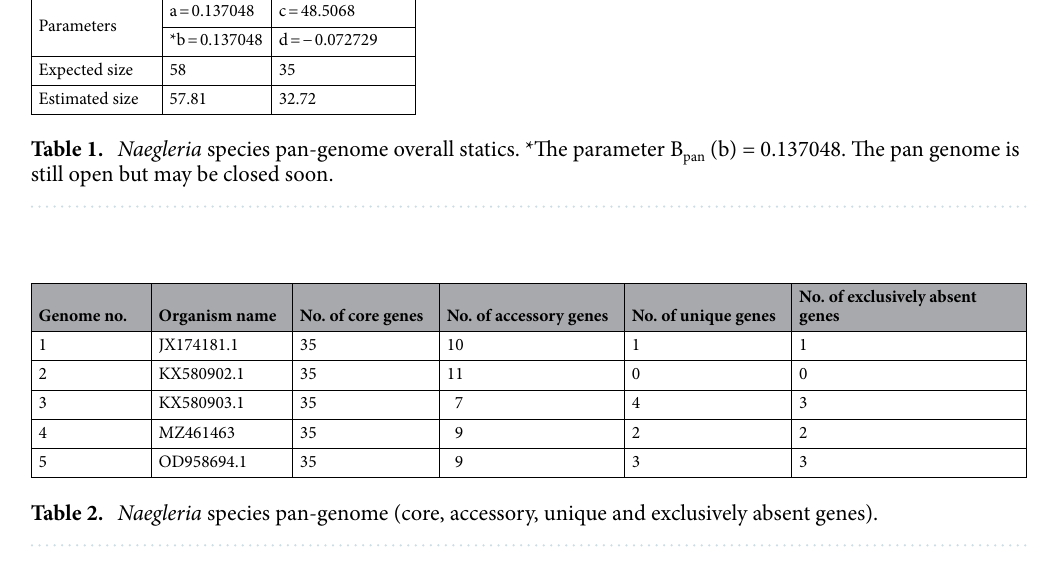
Table 2. Naegleria species pan-genome (core, accessory, unique and exclusively absent genes).